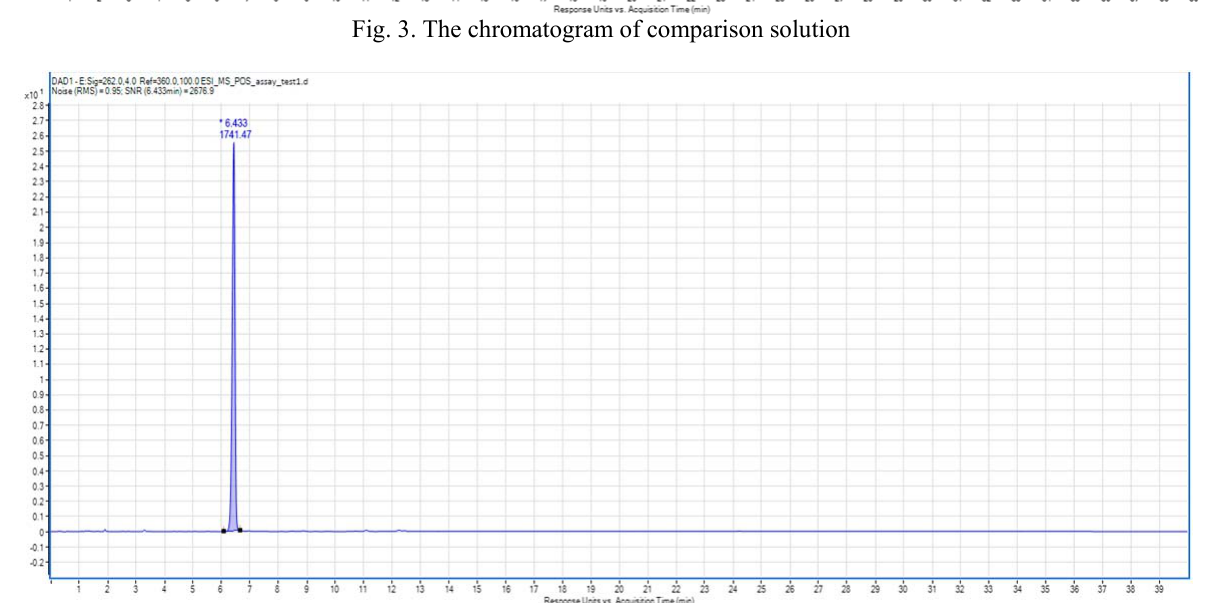
Fig. 4. The chromatogram of researched solution